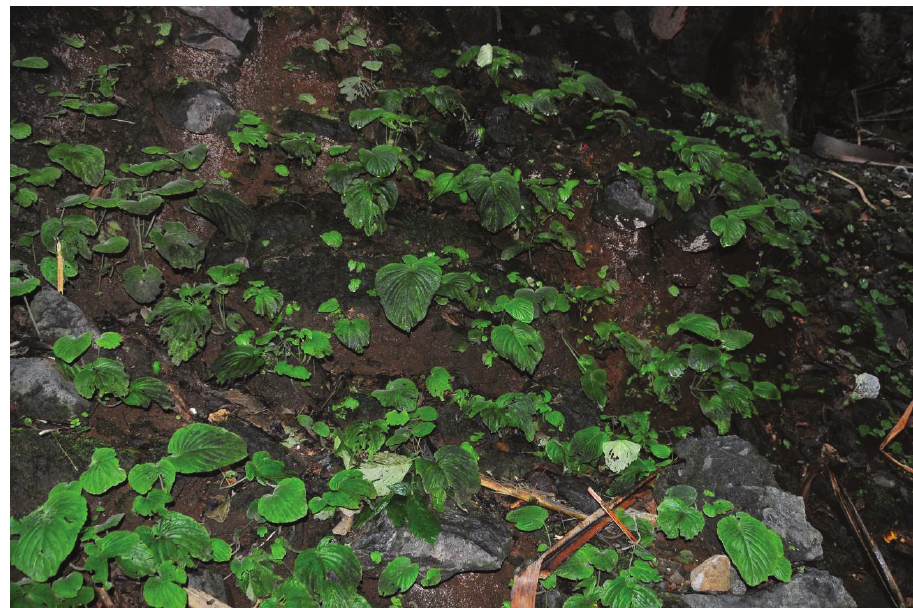
Figure 5. Epithema parvibracteatum (Gesneriaceae), endemic to Batu Caves.